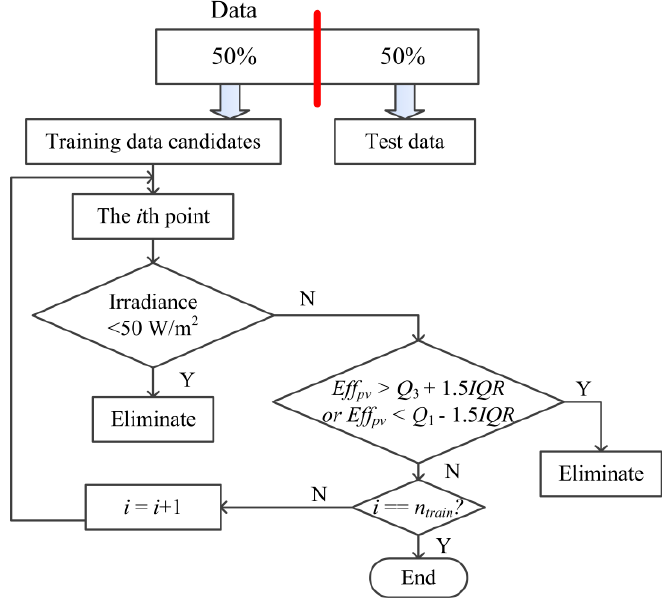
Figure 3. Flowchart of the data preprocessing.